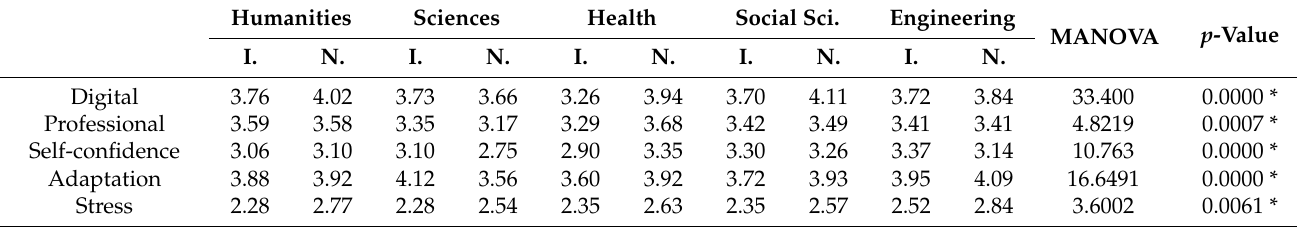
Table 13. Mean values of the subscales of the survey differentiating by digital generation and area of knowledge (I. means digital immigrants and N. means digital natives) and statistics of the MANOVA test (mean values out of